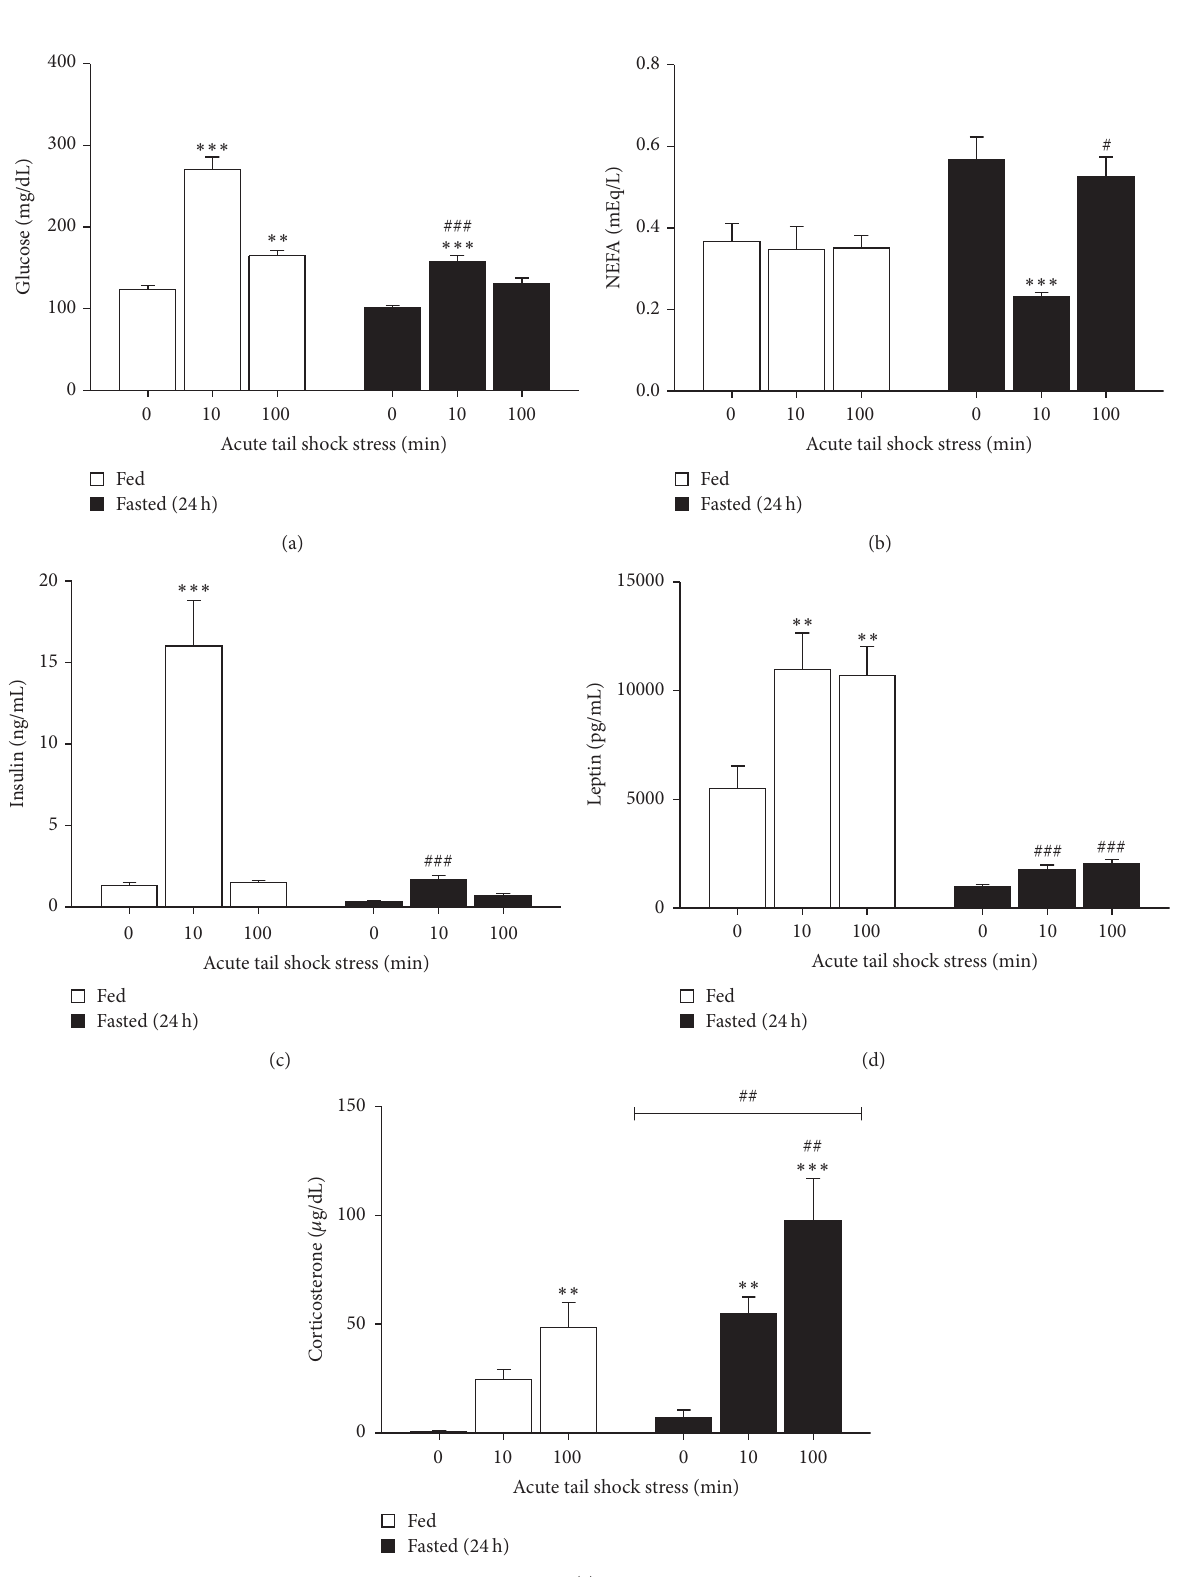
Figure 4: Effect of a 24h fast on the glucose, NEFA, insulin, leptin, and corticosterone response to 10 or 100 acute inescapable tail shocks in blood plasma. Fed (FED ◻ ) or fasted (FASTED ◼ ) rats were exposed to 0 (control condition), 10, or 100 acute, inescapable tail shocks (IS) and immediately sacrificed and trunk blood was collected. Shown is the mean (+SEM) plasma concentration of (a) glucose, (b) nonesterified fatty acids (NEFA), (c) insulin, (d) leptin, and (e) corticosterone. ∗∗ 𝑝 < 0.001 , ∗∗∗ 𝑝 < 0.0001 (0IS versus 10 or 100IS), ## 𝑝 < 0.001 (main effect of FED versus FASTED), # 𝑝 < 0.01 , ## 𝑝 < 0.001 , and ### 𝑝 < 0.0001 (FED versus FASTED within stress